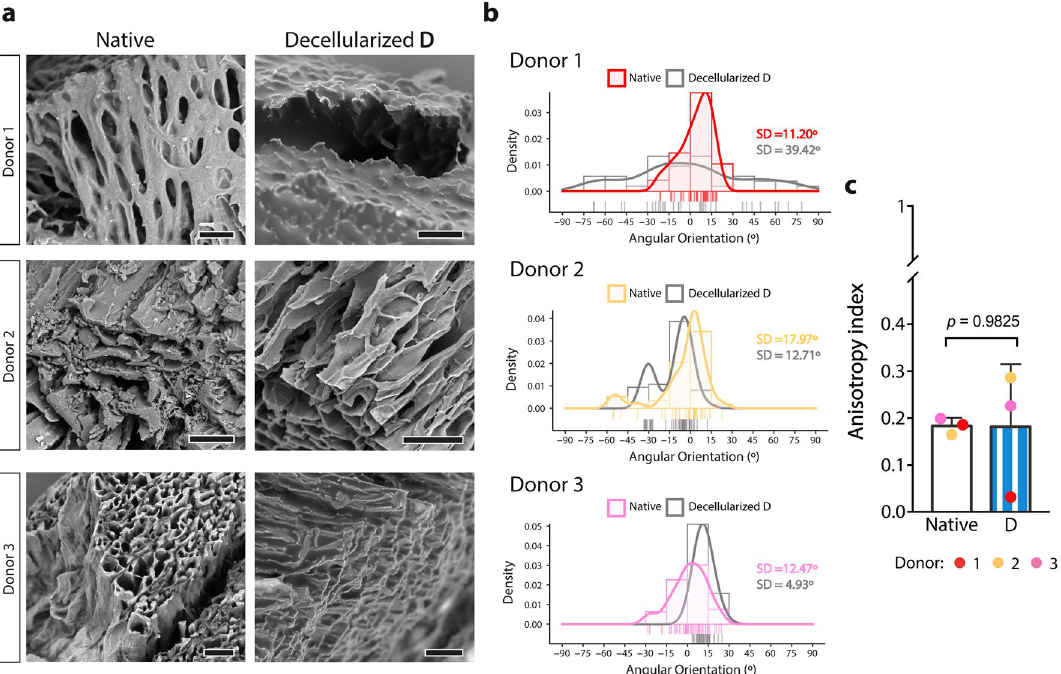
Figure 3. Scanning electron microscopy analysis of native and decellularized human cardiac tissue. ( a ) Architecture of native cardiac tissue and the decellularized scaffold using method D. Scale bars: 50 µm. ( b ) Density histogram of extracellular matrix fiber orientation of native and decellularized tissue using method D ( n = 35–55 ROI analyzed per condition per tissue donor). ( c ) Anisotropy index (0—random alignment/isotropic array, 1—perfect alignment/purely anisotropic array) of native and decellularized tissue using method D ( n = 3; two-tailed unpaired t -test). Data are represented as mean ±